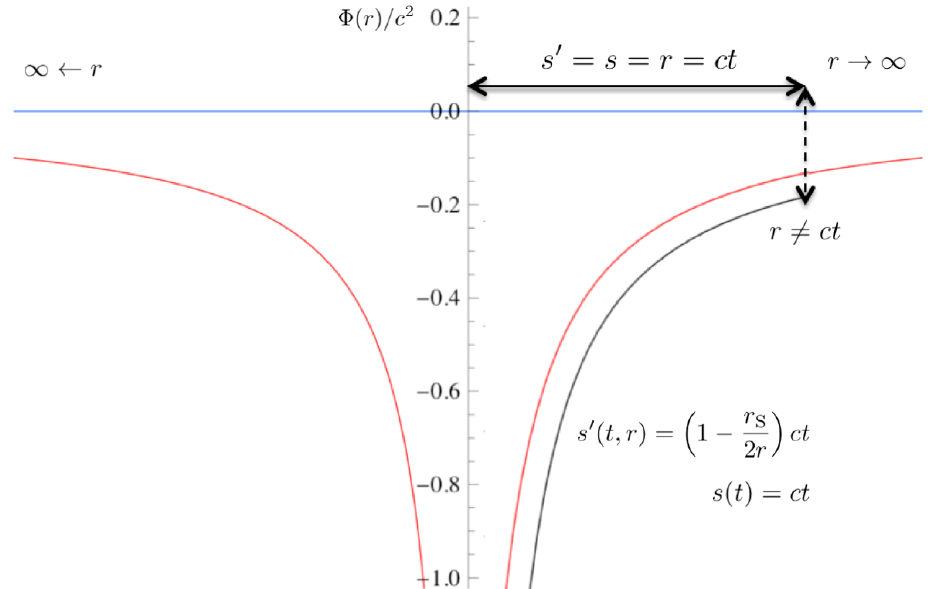
Figure 1. If the gravitational field of the particle is considered negligible, space-time is approximately flat (blue line). In this case, a photon emitted from the particle at r = 0 travels to a detector at the point r ( t ) = ct in time t . This completes a measurement of the space-like interval s ( t ) = ct . During this time (ignoring recoil), the particle traverses a time-like interval s (cid:48) ( t ) = ct , so that s (cid:48) ( t ) = s ( t ) = r ( t ) = ct . Taking the particle’s gravity into account (red line), if the photon travels from r = 0 to r > 0 in time t , this corresponds to a measurement of the space-like interval s (cid:48) ( t , r ) (cid:39) ( 1 − r S /2 r ) ct , ( r (cid:54) = ct ) . The time-like interval traversed by the particle is still s ( t ) = ct , so that s (cid:48) ( t , r ) (cid:39) ( 1 − r S /2 r ) s ( t ) . This formula relates the perturbed line element s (cid:48) ( t , r ) to the unperturbed line element s ( t ) or, equivalently, the space-like interval measured at r to the “true” time-like interval traversed by the particle. Hence, the relation between s (cid:48) and s obtained from Károlyházy’s measurement procedure, using classical particles, is equivalent to the perturbative result. This procedure may be generalised to measure larger distances via multi-photon absorption at r